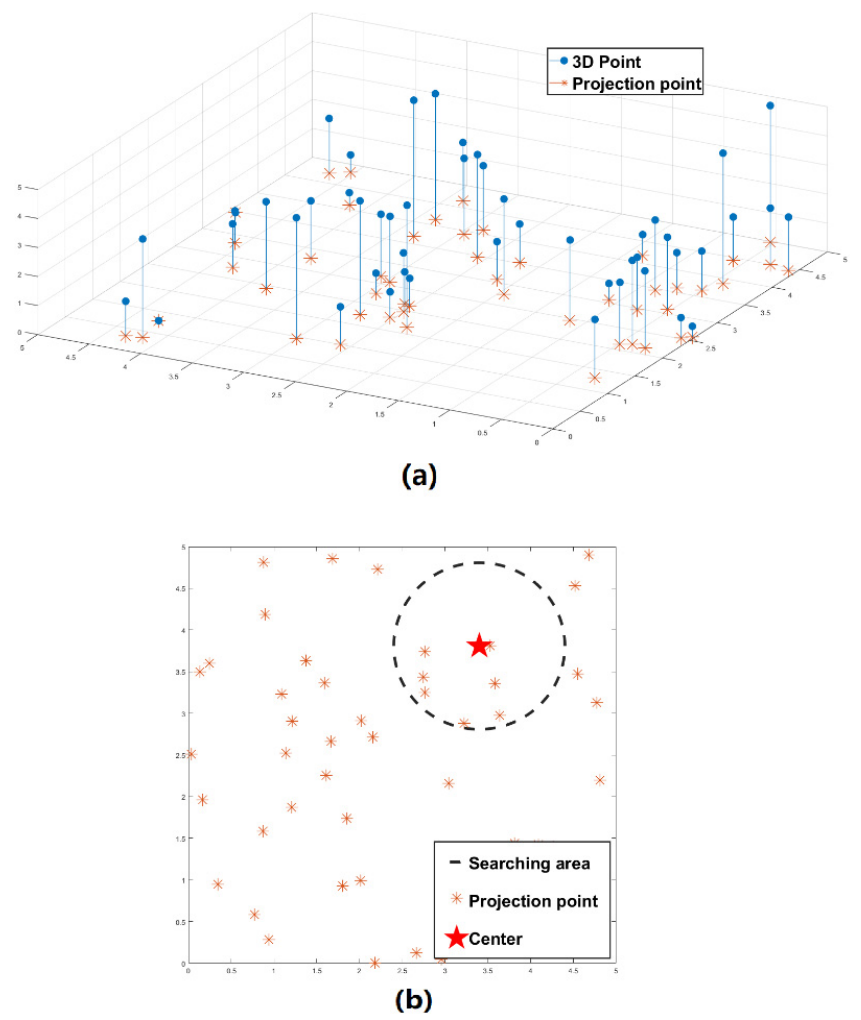
Figure 3. ( a ) Point-cloud projecting; ( b ) OPN counting. Points in three-dimensional space (blue ones) are projected onto a two-dimensional plane (orange ones) by only retaining their x and y coordinates. Taking the red pentagram as a center point, with its searching area circled in black, the OPN of the point, marked as the red pentagram, can be counted as 7.